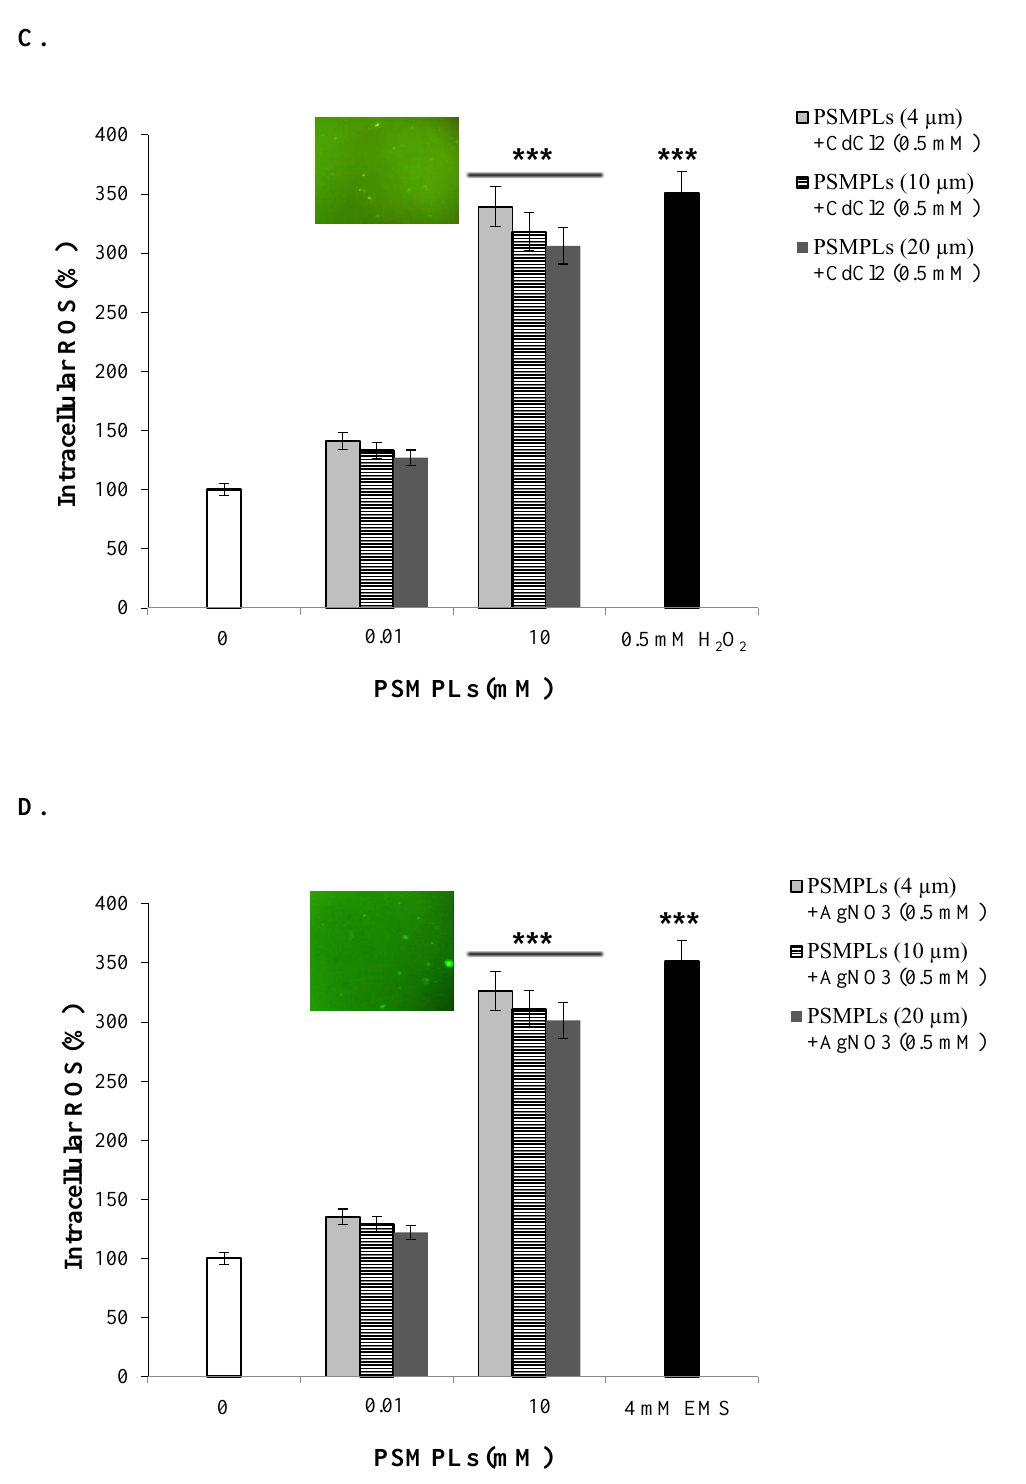
Figure 4. ROS production in hemocytes of third instar of untreated (0) and treated larvae ex- posed to different concentrations of PSMPLs ( A ), CdCl 2 and AgNO 3 ( B ), PSMPLs + CdCl 2 ( C ), and PSMPLs + AgNO 3 ( D ). Hemocytes were incubated with 5 µ M of DCFH-DA at 24 ◦ C for 30 min and observed using fluorescent microscopy. The fluorescence intensity of the hemocytes of exposed larvae with permethrin were quantified by ImageJ analysis. A total of 0.5 mM of H 2 O 2 was used as positive control. *** p ≤ 0.001 when compared to the negative control by the Mann–Whitney